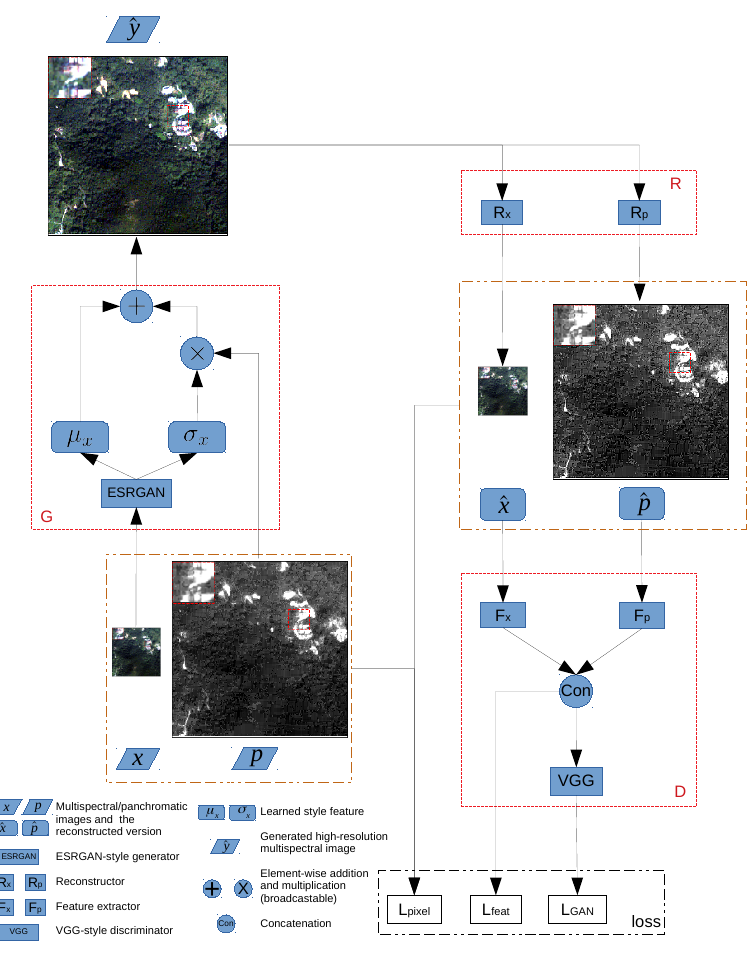
Figure 3. The structure of the proposed PercepPan. G , R , and D denote Generator, Reconstructor, and Discriminator,